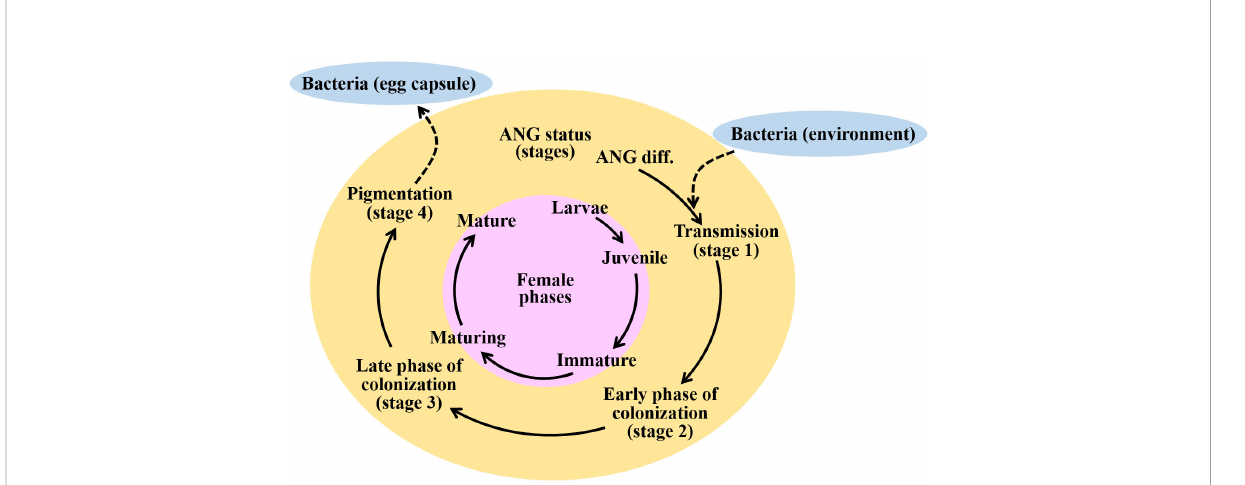
FIGURE 1 Schematic diagram representing the ANG developmental statues during female maturation in big fi n reef squid. Initially, the bacterial consortium of the ANG is populated by horizontal transmission from the environment. Four developmental stages of the ANG can be identi fi ed through gonadal and ANG characteristics. Bacterial transmission (stage 1), juvenile squid with primary oocytes, a colorless ANG, and no visible bacterial fl ora; early phase of bacterial colonization (stage 2), immature squid with previtellogenic oocytes, a colorless ANG, and bacterial fl ora; late phase of bacterial colonization (stage 3), maturing squid with early vitellogenic oocyte, a white/light-orange ANG, and a large number of bacterial fl ora; bacterial pigmentation (stage 4), mature squid with mature eggs observed in oviduct, a pigmented ANG, and large numbers of bacterial fl ora (stage 4). Finally, these symbiotic bacteria are transmitted to the jelly coat of the egg. Pink, yellow, and green colors indicate the female phases and ANG stages, respectively. Blue color indicates the marine environment. Dash lines indicate the horizontal transmission of bacteria from the marine environment to ANG or bacteria releasing from ANG to egg